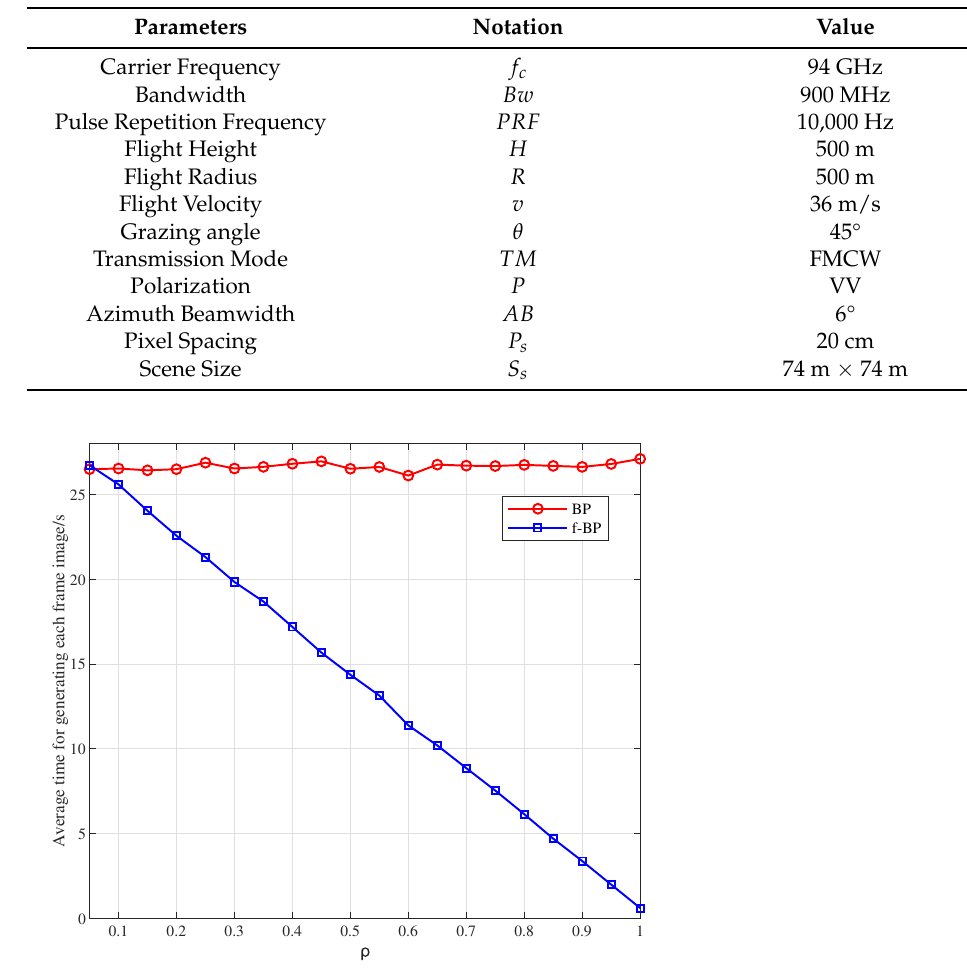
Table 1. Radar parameters for W-band video SAR data